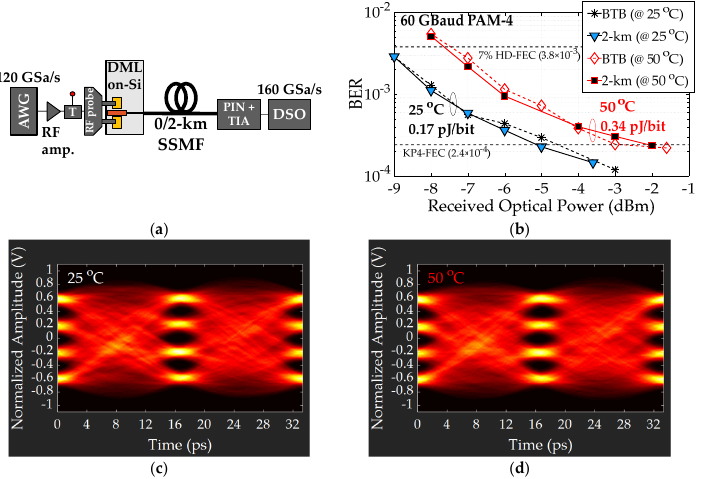
Figure 5. 60 GBaud PAM-4 signal evaluation: ( a ) Experimental setup; ( b ) Bit-error rate (BER)